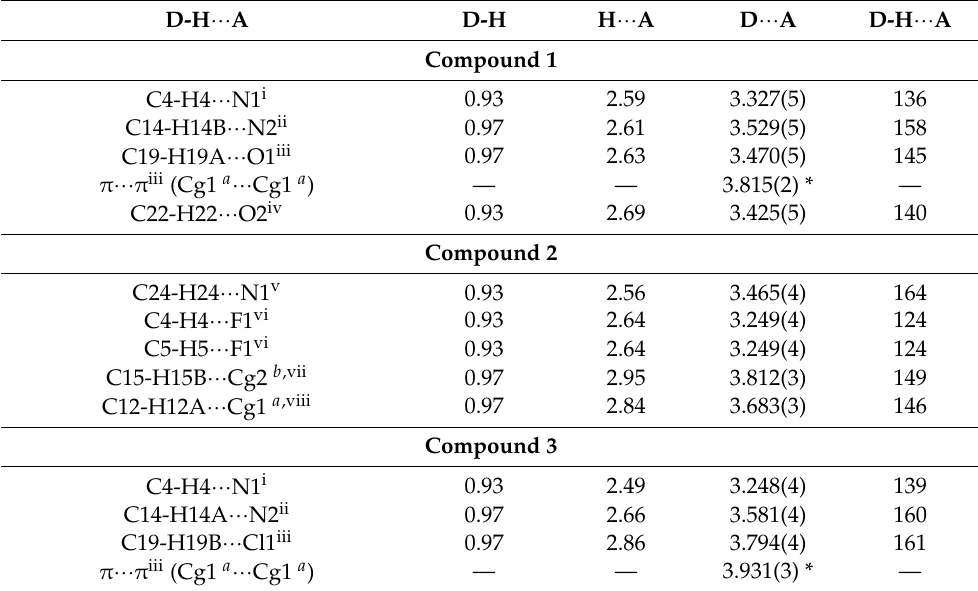
hydrogen bridge. a Cg1 is the centroid of the C20/C25 ring. b Cg2 is the centroid of the C1/N1